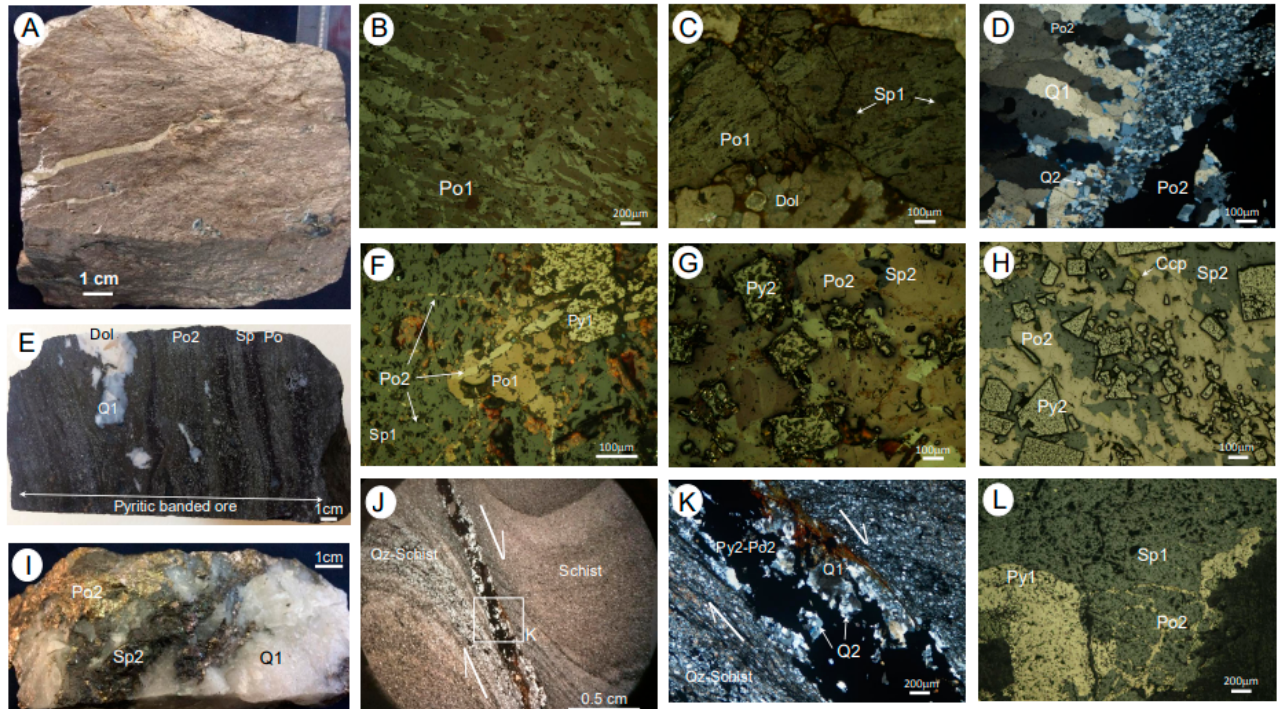
Figure 3. Mineralogy of Koudiat Aïcha: early stages. ( A ) Hand specimen showing the pyrrhotite- dominated massive ore. Optical microscope observation: ( B ) Deformed pyrrhotite 1 from massive ore. ( C ) Brecciated massive early ore with pyrrhotite 1 and sphalerite 1 empacked in dolomite matrix. ( D ) Quartz 1 vein crosscutting sandy schist and quartz 2, pyrrhotite 2 filling quartz 1 veins and sandy schist. ( E ) Hand specimen showing banded “pyrtic ore” enveloping quartz 1 fragments overgrown by dolomite. ( F ) Pyrrhotite 1, pyrite 1 and sphalerite 1 crosscut by pyrrhotite 2. ( G , H ) Pyrite 2 overgrown by pyrrhotite 2 and sphalerite 2. ( I ) Hand specimen showing ore breccia of quartz 1 fragments enveloped by pyrrhotite 2 and sphalerite 2. ( J ) Microshear zone crosscutting schist and sandy microlayers and infilled with quartz 1–sulfide–chlorite–mica. ( K ) Detail of picture ( J ) Microshear zone infilled with quartz 1 and quartz 2, pyrite 2, pyrrhotite 2 and crosscutting sandy schist microlayers. ( L ) Pyrrhotite 2 enveloping and crosscutting sphalerite 1 and pyrite 1 in ore breccia. Po: pyrrhotite, Sp: sphalerite, Py: pyrite, Ccp: chalcopyrite, Q1: quartz, Dol: dolomite, Qz-schist: sandy schist.